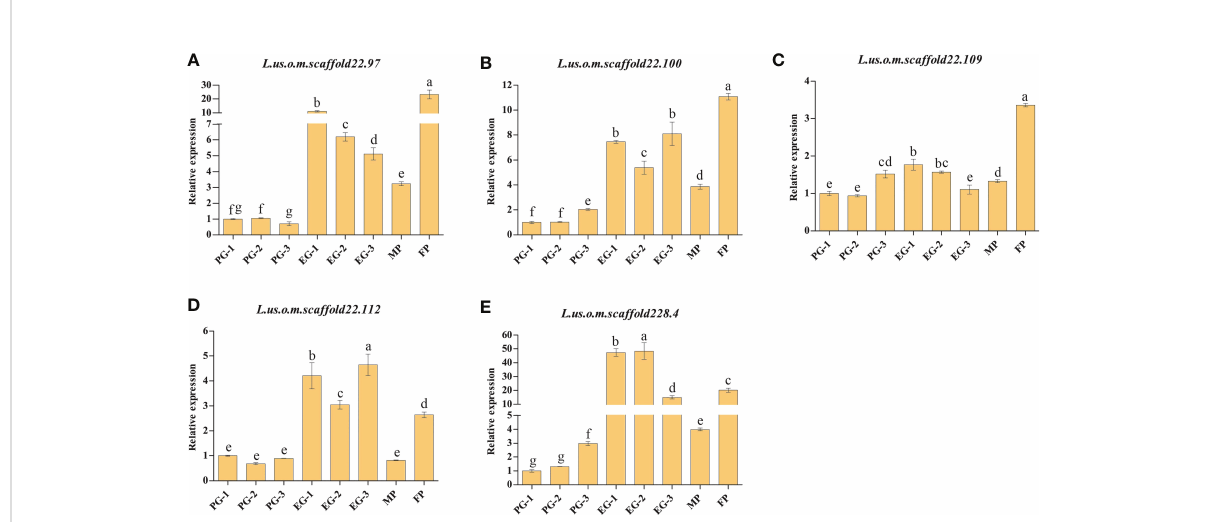
FIGURE 4 qRT-PCR analysis of the candidate genes in the parental plants and F 3 generations. (A) L.us.o.m.scaffold22.97 ; (B) L.us.o.m.scaffold22.100 ; (C) L.us.o.m.scaffold22.109 ; (D) L.us.o.m.scaffold22.112 ; (E) L.us.o.m.scaffold228.4 . MP: male parent; FP: female parent; PG: the basal section of stems from F 3 generation with prostrate growth habit; EG: the basal section of stems from F 3 generation with erect growth habit. The data are represented as mean ± SD of three biological replicates. The lowercase letters above the bars indicate the signi fi cant differences at the 0.05 probability level.